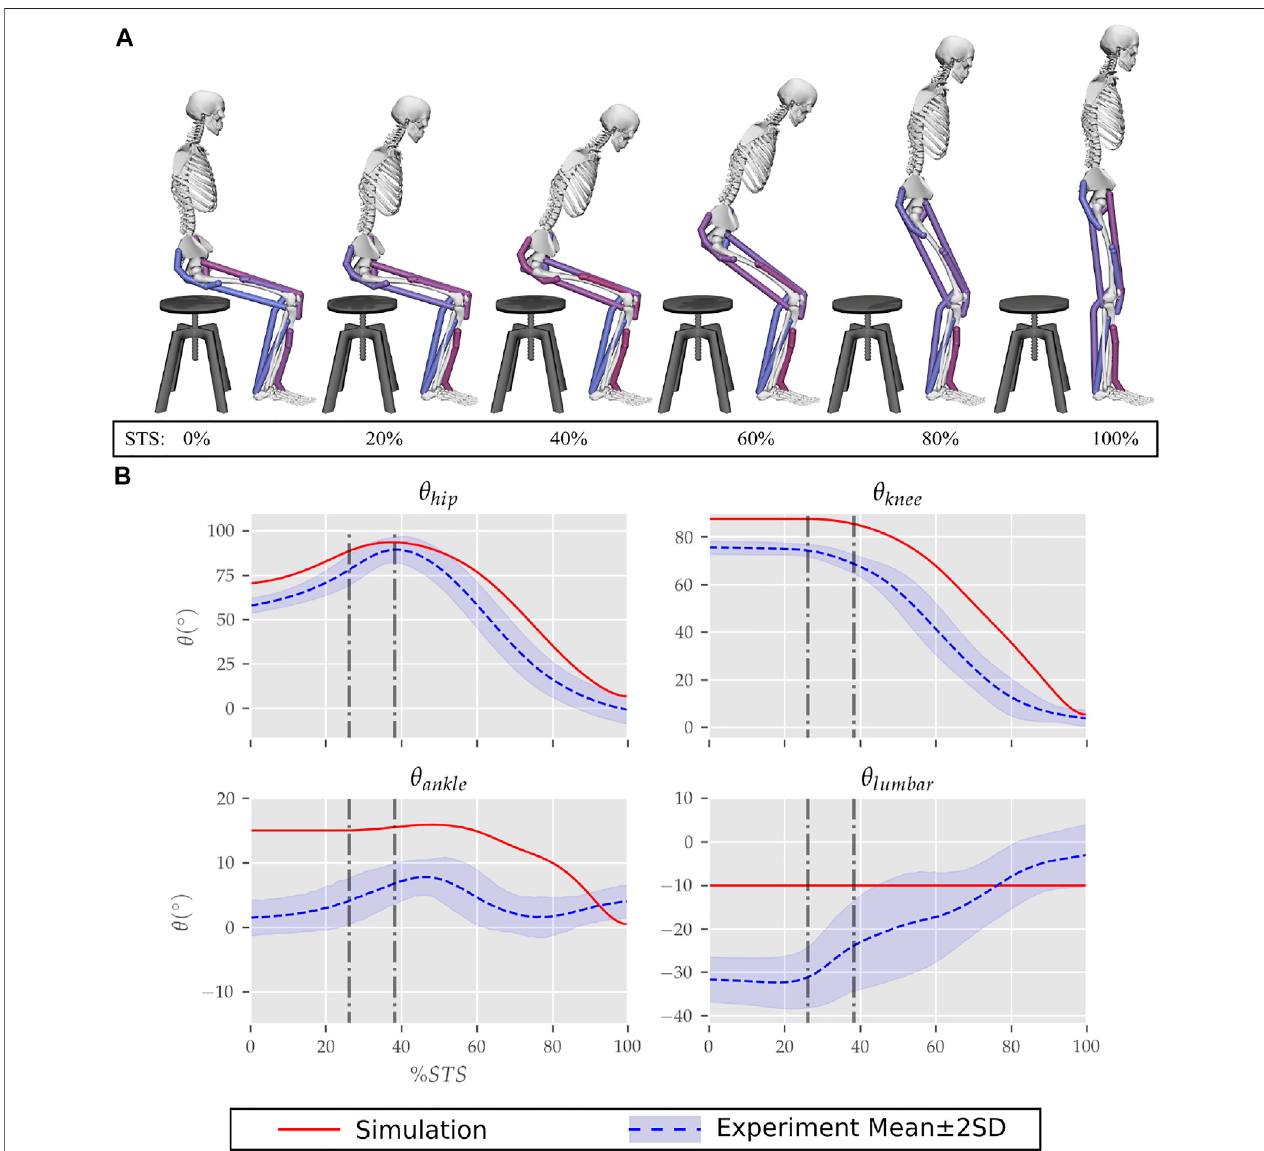
FIGURE 6 | (A) Different postures observed during the 0% strength de fi cit model ’ s STS transition and (B) the comparison of associated joint angle trajectories againstexperimental observations. The fi rst verticaldotted linemarksthe point when the model lost contact with thechair, and thesecond vertical dotted line marks the posture with maximum hip fl